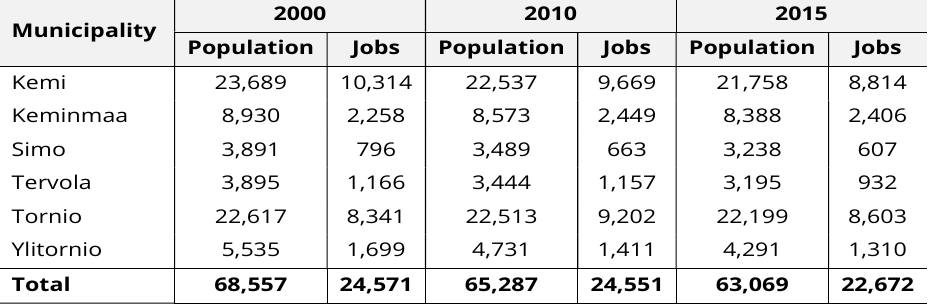
Table 2. Population and job development 2000–2015 (Tilastokeskus